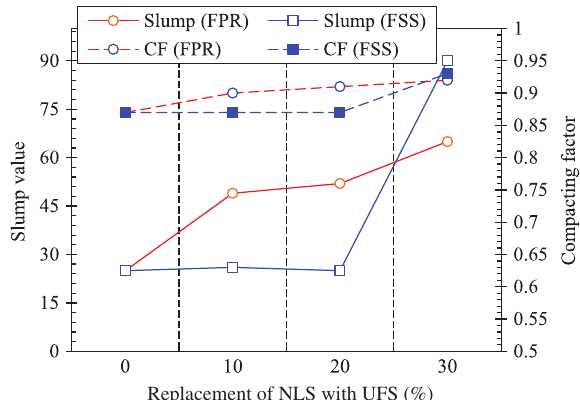
Figure 6: Workability of concrete at different replacement levels of NLS with UFS.